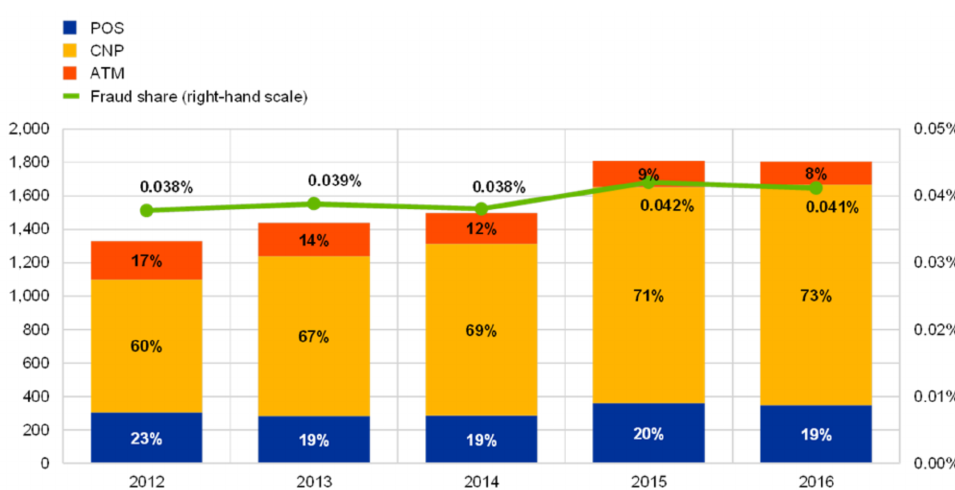
Figure 2. Evolution of the total value of card fraud using cards issued within Single Euro Payments Area. Figure 3 shows simplified authorization and fraud detection